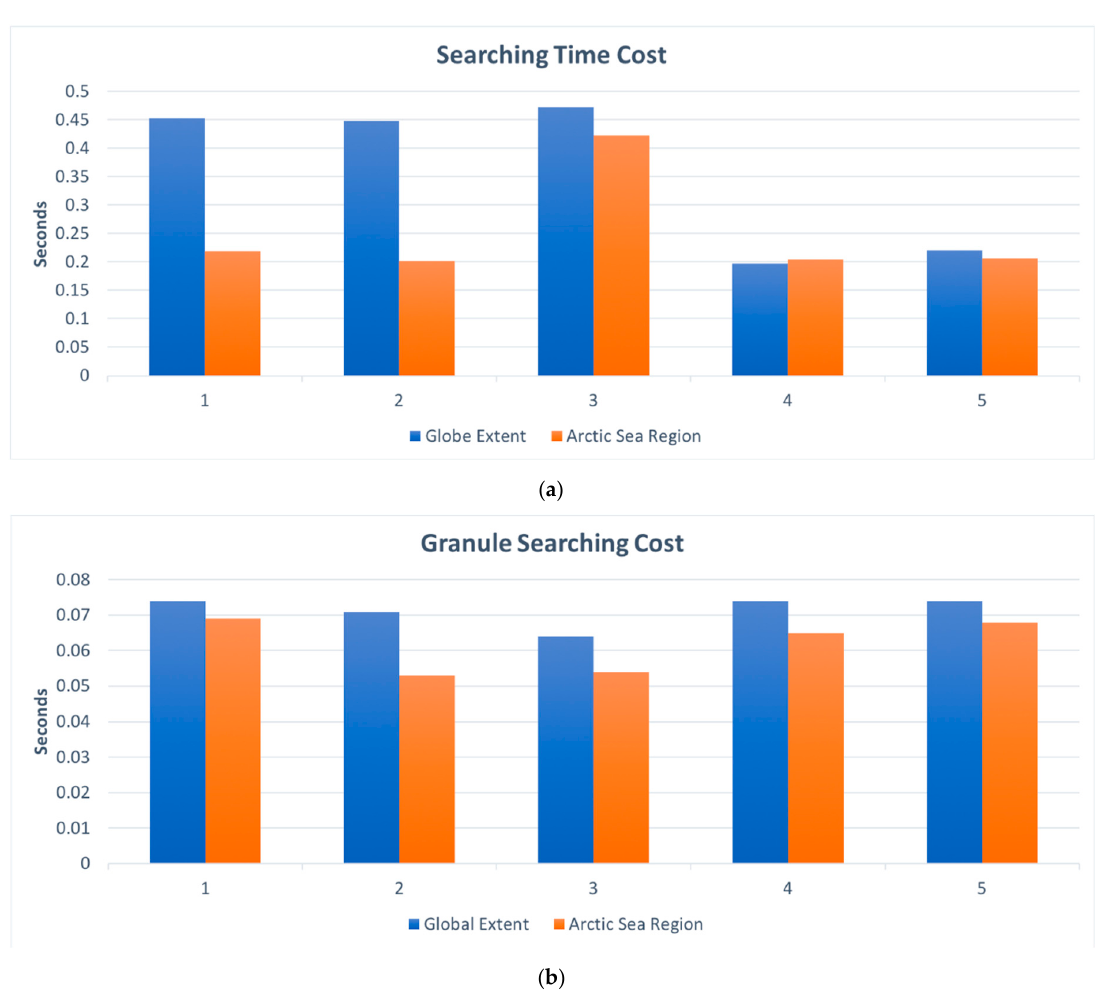
Figure 16. Performance comparison (time in seconds) of the traditional harvesting approach ( a ) and our approach ( b ), sampled 5 times for crawling 125 records.